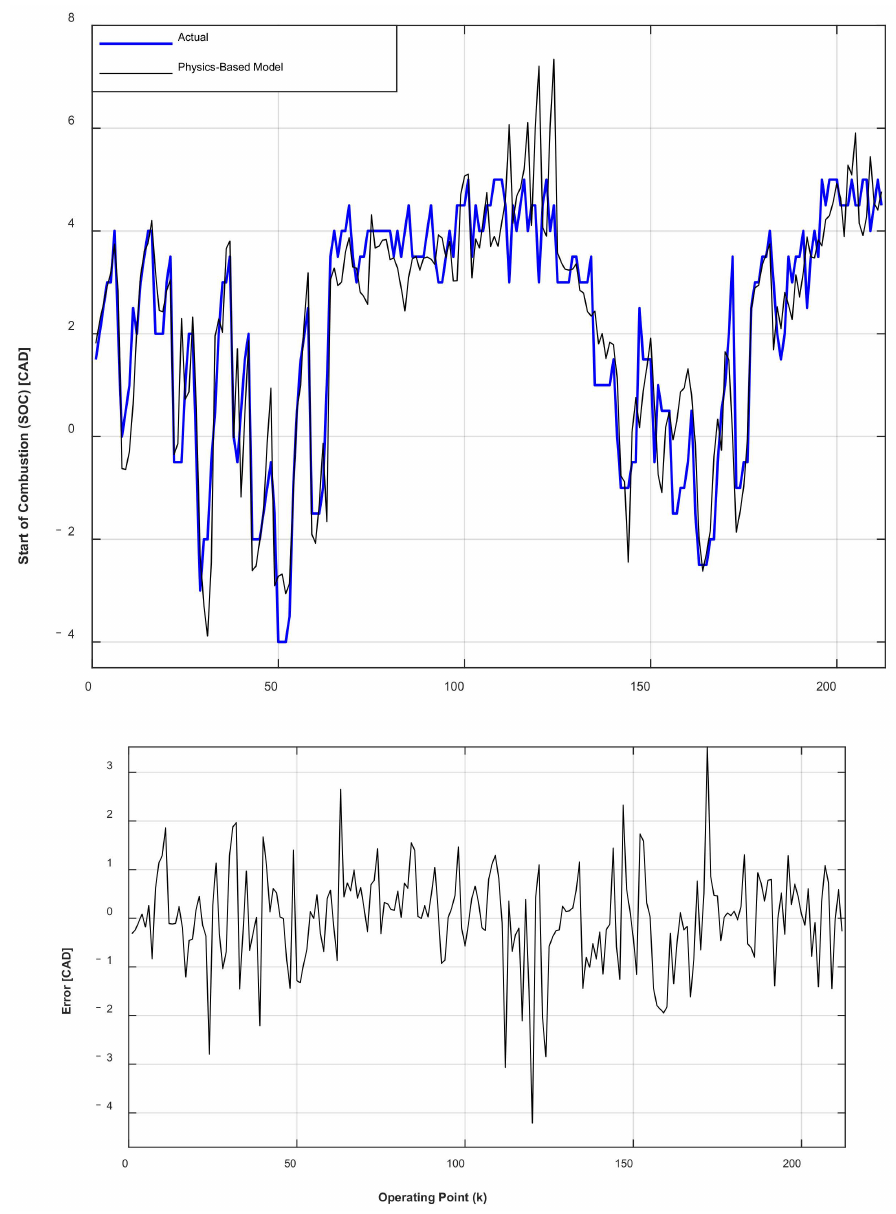
Figure 9. Comparison of the physics-based SOC model and actual